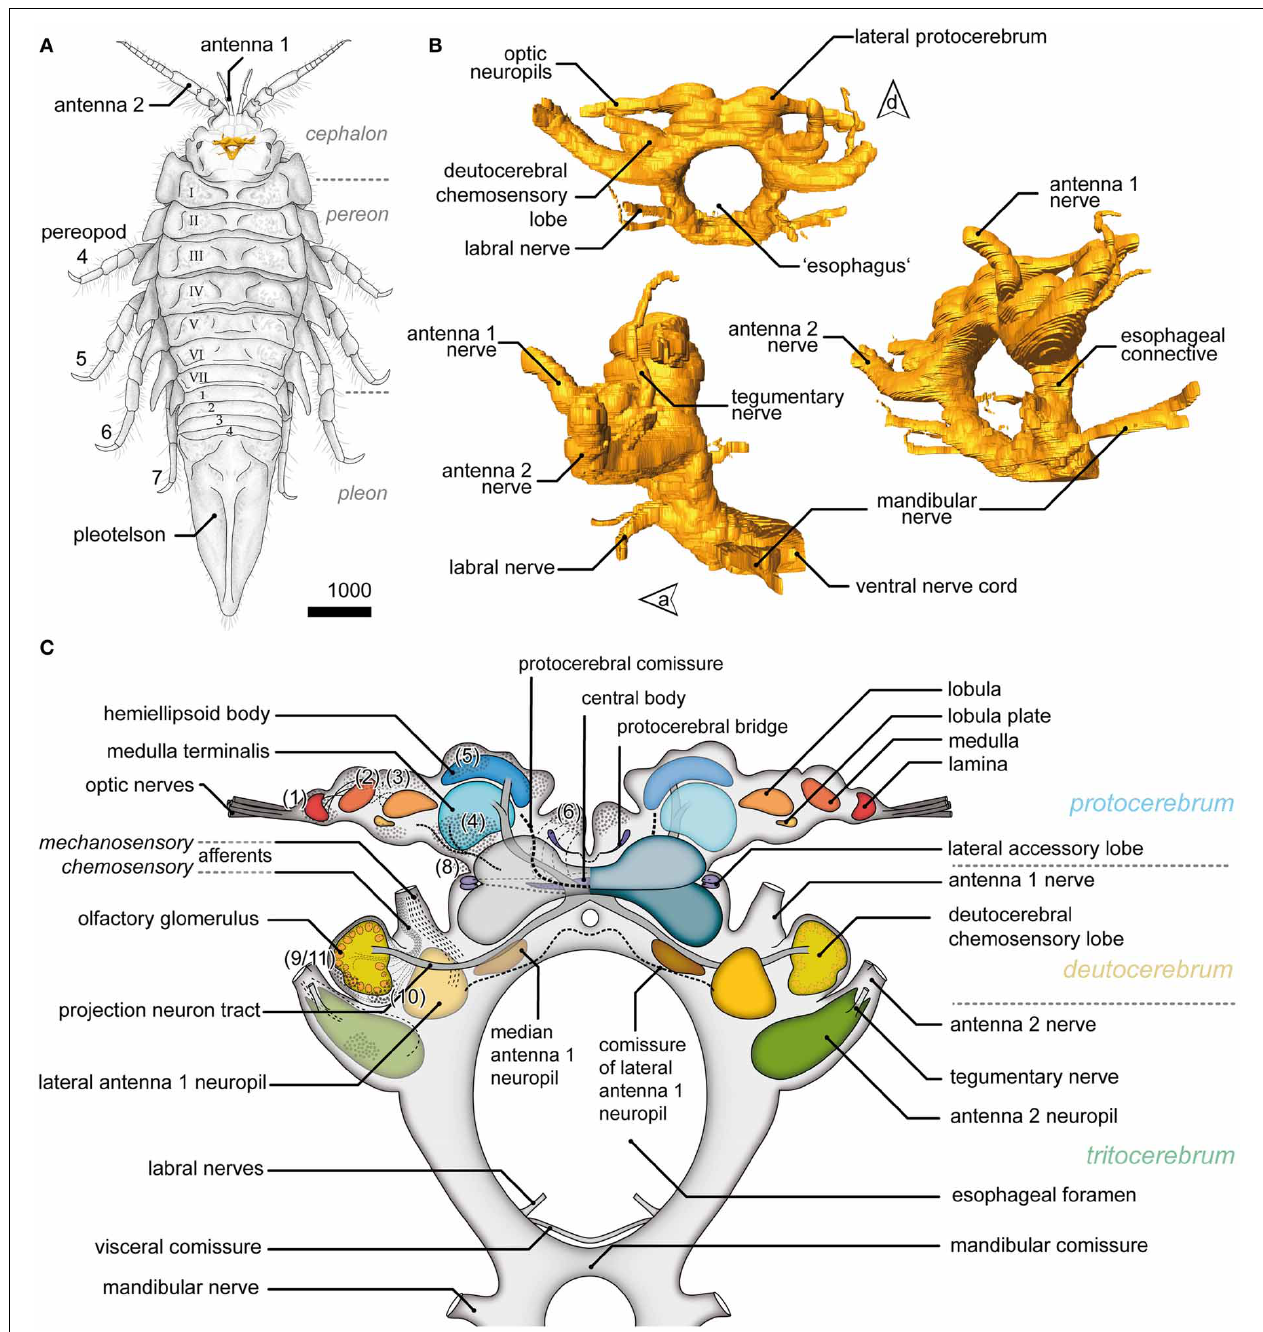
FIGURE 2 | General overview of the brain in Saduria entomon . (A) A sketch of Saduria entmon showing the position and relative proportion of the brain. (B) 3D reconstruction of the brain from frontal (top left), lateral